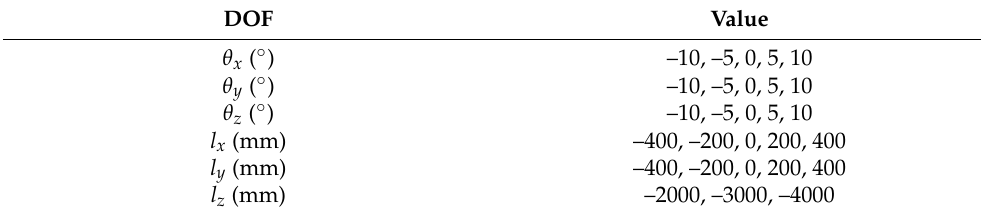
Table 1. Values of six DOF set in the experiment.